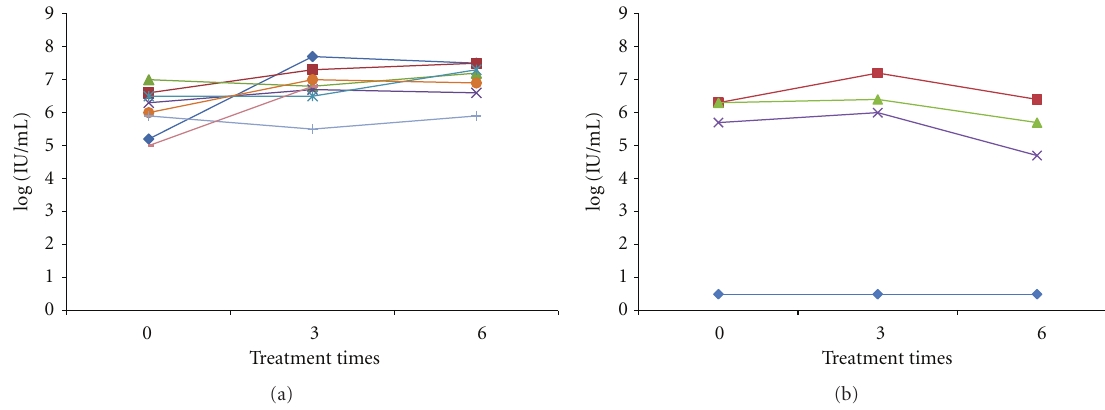
Figure 2: (a) The change in HCV-RNA in cases with treatment resistance or recurrence. (b) The change in HCV-RNA in cases that maintained remission. In many cases that showed treatment resistance or recurrence, HCV-RNA levels transiently increased after the third anti-cancer treatment compared to pretreatment levels. Although in two cases HCV-RNA level decreased compared to pre-treatment level, values were higher than the pre-treatment level after the sixth treatment. In contrast, in some of the cases that maintained remission, HCV- RNA levels increased transiently after the third treatment, but after the sixth treatment decreased to lower than pre-treatment levels.